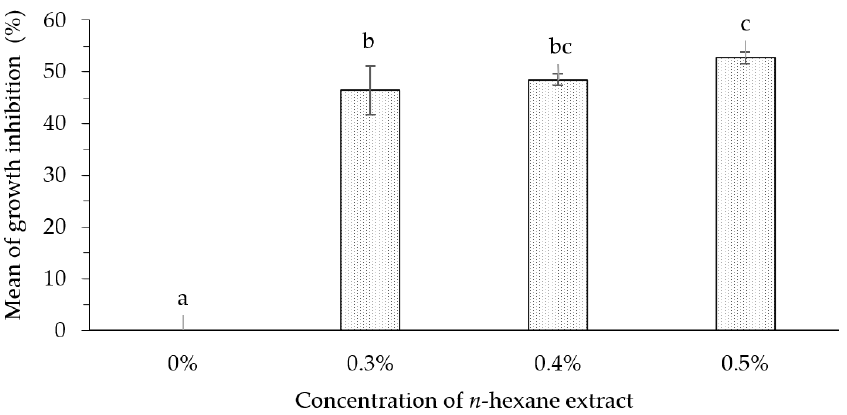
Figure 3. Mean of growth inhibition of the n -hexane extracts, with concentrations of 0% (control solution), 0.3%, 0.4%, and 0.5% on the growth of A. foetidus fungus. Notes: the same letter on the statistic bar indicates no significant difference ( p < 0.05).